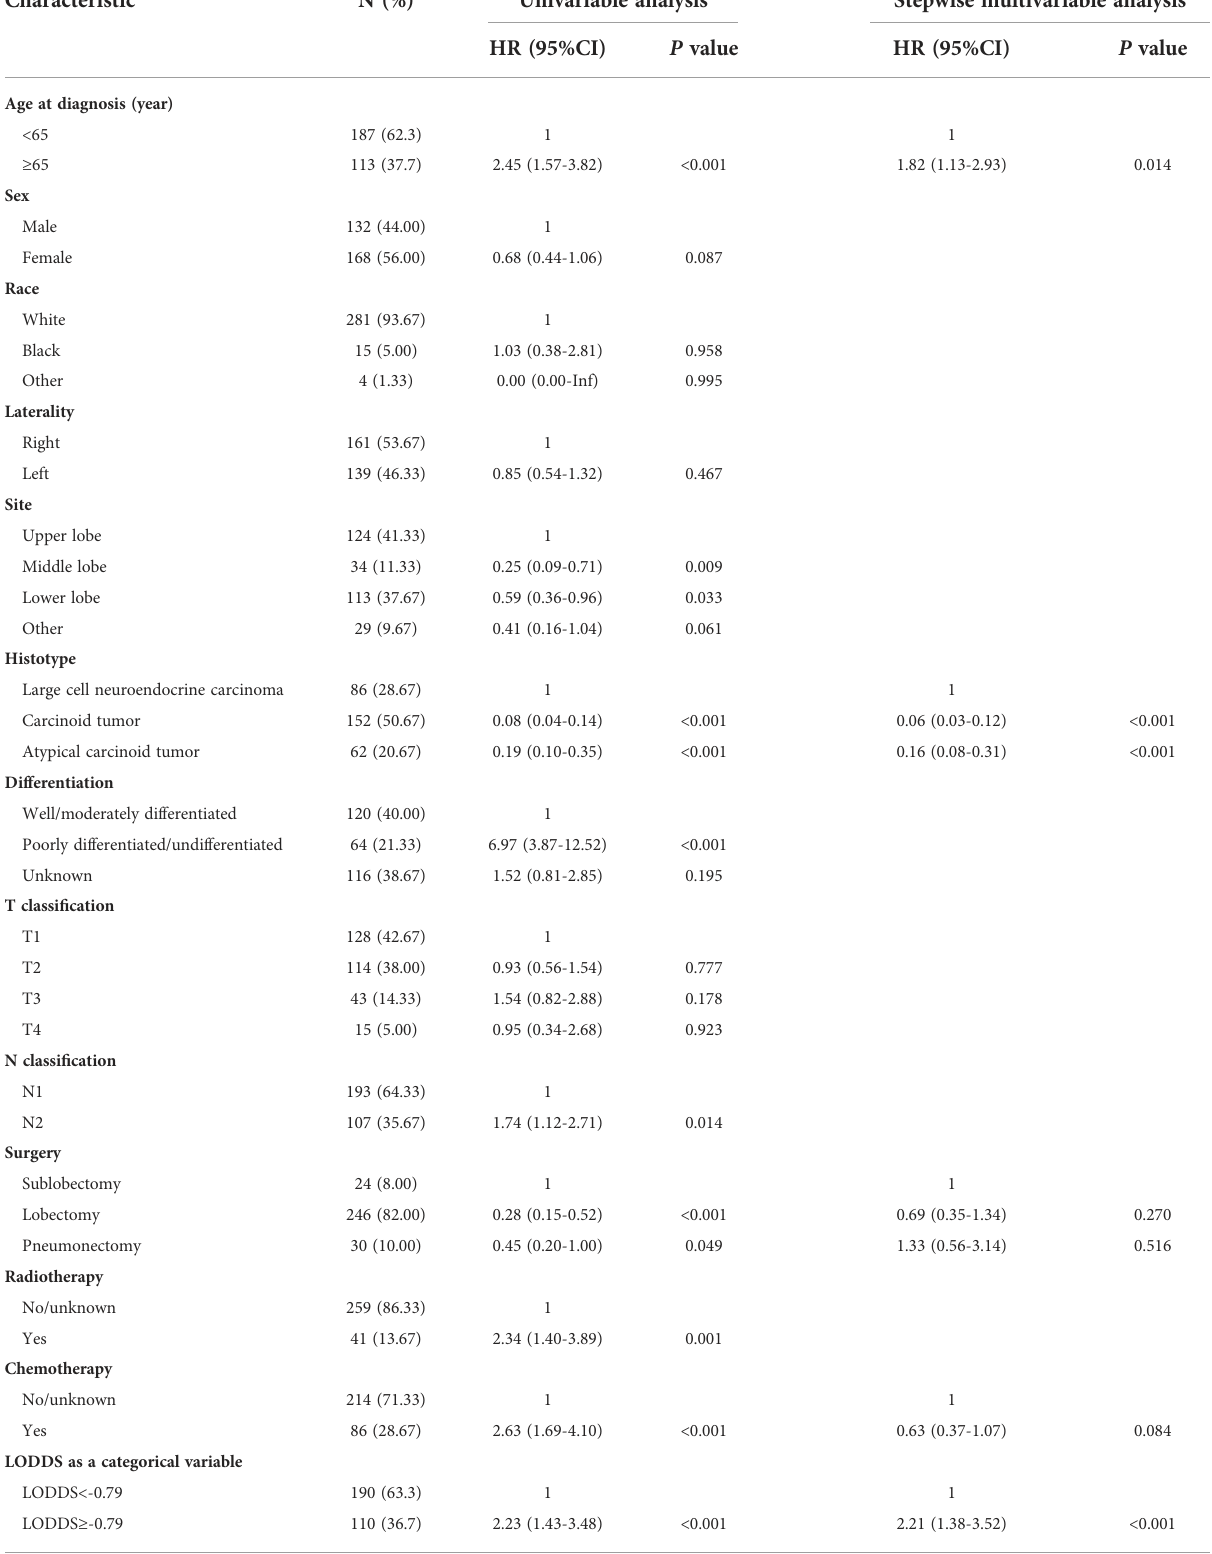
TABLE 2 Univariable and stepwise multivariable Cox proportional regression analysis for CSS of the derivation dataset.